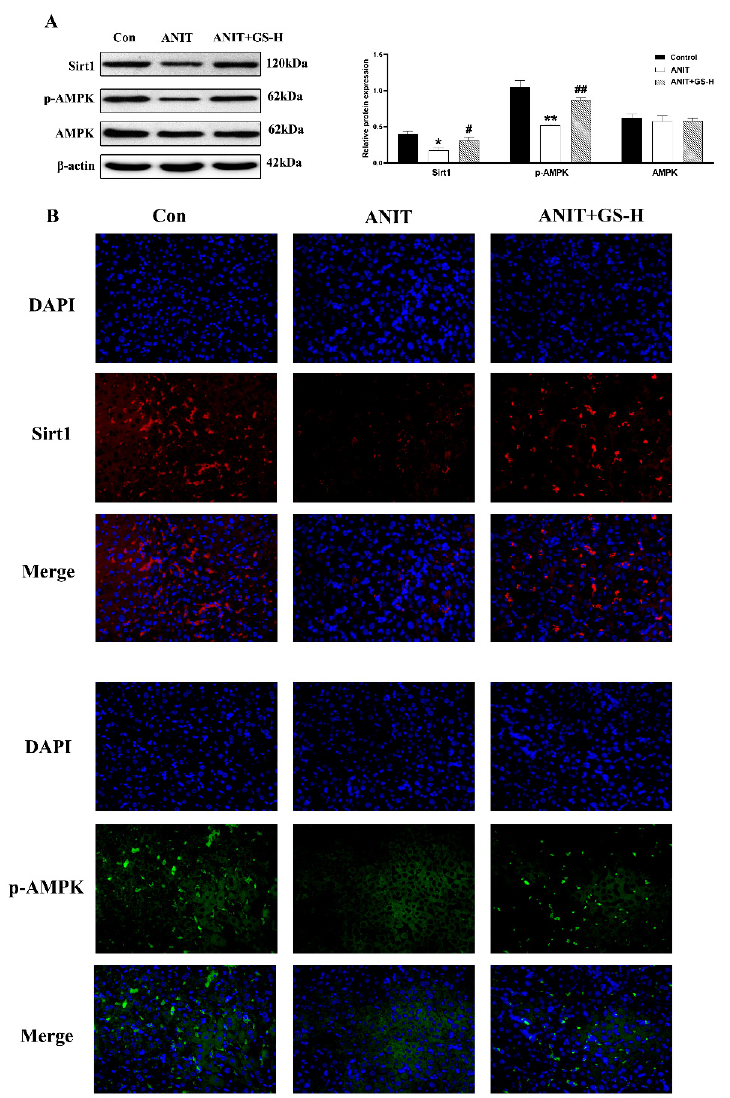
Figure 7. GS treatment improved the protein expression level of SIRT1/AMPK. ( A ) The protein expression levels of SIRT1, p-AMPK, and AMPK. ( B ) Immunofluorescence stainings for SIRT1 and p-AMPK protein levels in liver tissue. Significantly different from control, * p < 0.05 or ** p < 0.01, or ANIT, # p < 0.05 or ## p < 0.01.